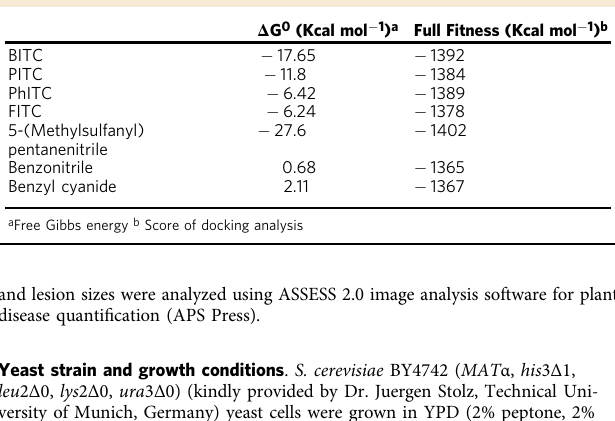
Fig. 8 Phylogenetic and structural analysis of mfsG and mfs-like proteins. a Phylogenetic analysis was performed using amino-acid sequences of MFS proteins with at least 40% identity to mfsG from different fungi. All of these sequences were clustered into two clearly differentiated clades. One group contained B05.10 mfsG and similar proteins (yellow). The other clade consisted of three subclades: one of them (blue) contained B05.10 mfs-like1 and its homologs, and another (pink) contained B05.10 mfs-like2 and its homologs and a third that do not contain B05.10 homolog (black). Isolate name and protein ID are in parentheses. Bootstrapping (1000 replicates/iterations) was used to generate the phylogenetic tree with the neighbor-joining algorithm in MEGA7. b Alignment of amino-acid sequence of three MFSs from B. cinerea B05.10 ( mfsG , mfs-like1, and mfs-like2 ). Residues located in the proposed binding site to ITCs are highlighted (green triangles). c Three-dimensional structure and hydrophobicity representation of mfsG , mfs-like1 , and mfs-like2 from B. cinerea B05.10. d Comparison of three-dimensional structures of mfsG , mfs-like1 , and mfs-like2 grown in the dark at 22 o C on a freshly prepared PDA plate containing different Table 1 Thermodynamic parameters of molecular docking of concentrations of ITCs. The diameter of radial mycelial growth (D, in mm) was ITCs to